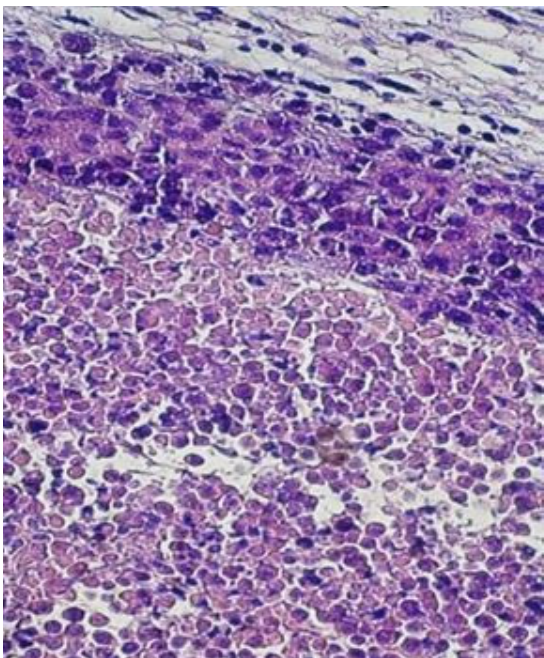
Figure 4. Histopathological demonstration of the outer margin of the tumor (magnification ×200). There is a clear boundary between the tumor and surrounding normal tissue. The outer part of the tumor appears to contain numerous macrophages.